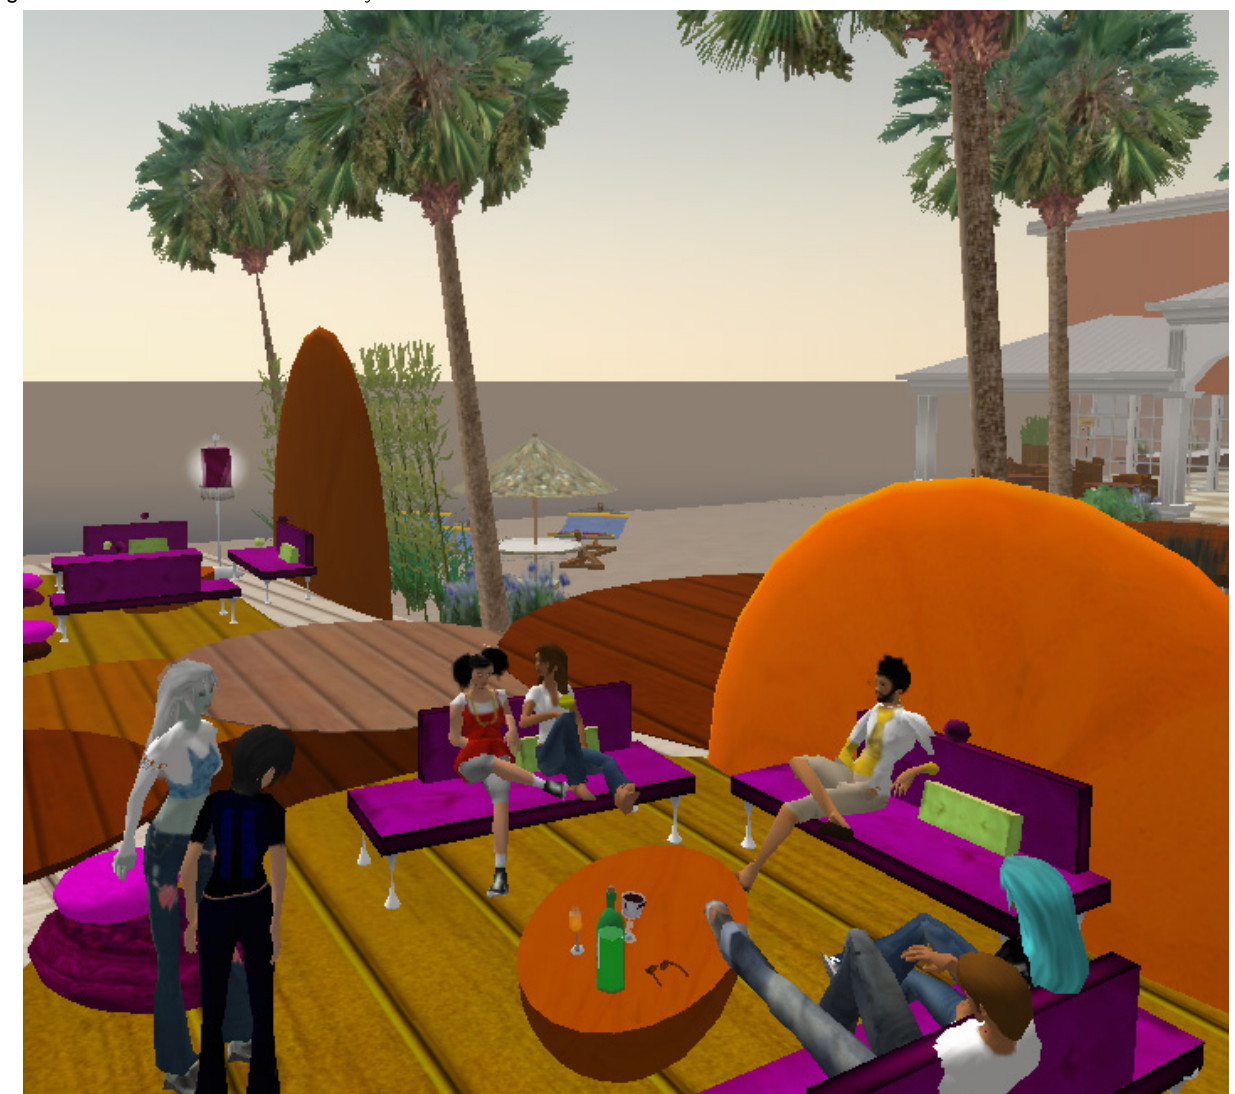
Figure 2. A screenshot from the Community